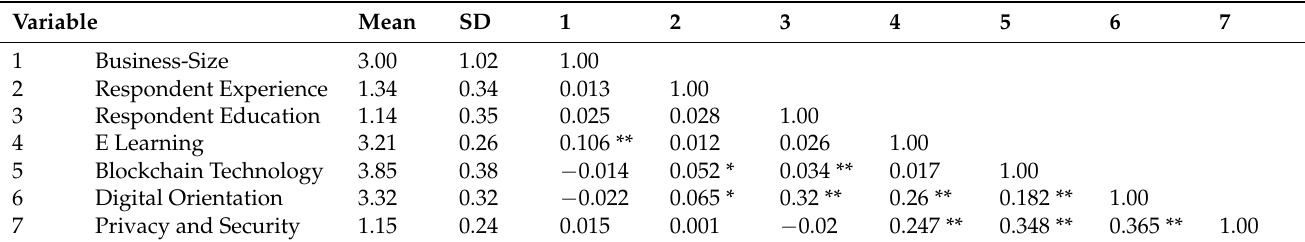
Table 3. Results of Mean, SD, and Correlations.